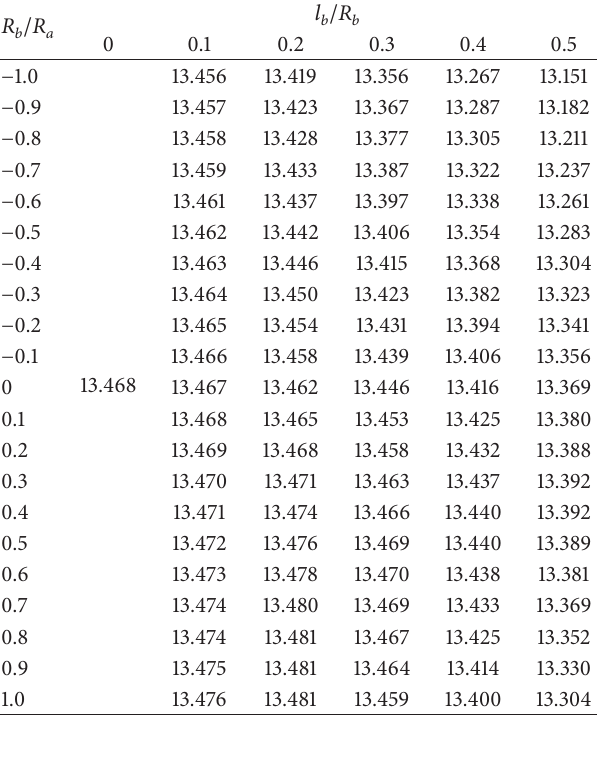
Table 10: The first frequency parameters of F-F-F-F shallow shells.